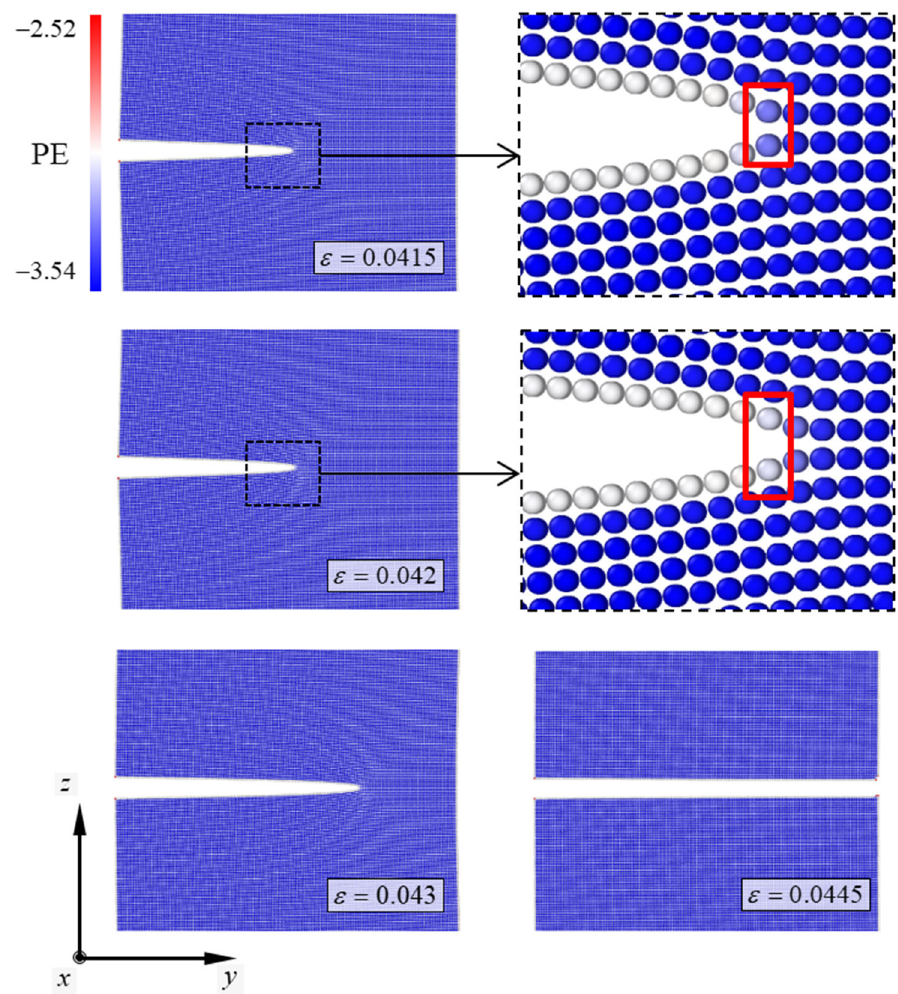
Figure 3. Atomic configurations depicting the fracture mechanism of the pure Cu specimen. PE denotes potential energy of the atom consisting of the simulation model. The numbers next to the color bar denote the range of the PE and the SI unit of the PE is eV. The atomic configuration in the solid line box shows the crack tip of the specimen in detail.